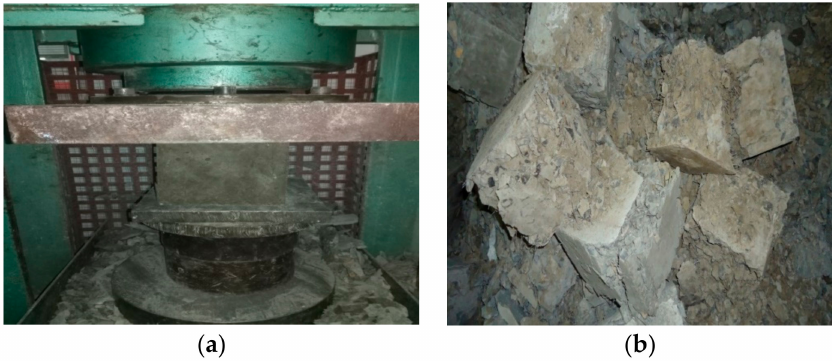
Figure 5. ( a ) The compressive testing of cubes; and ( b ) the failure samples.